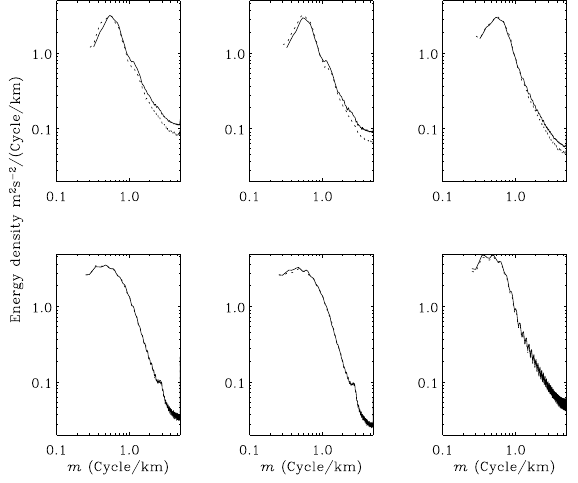
Fig. 4. Averaged vertical wave number spectra for the zonal ki- netic energy density (left column), meridional kinetic energy den- sity (middle column) and potential energy density (right column) in the troposphere (bottom row) and lower stratosphere (upper row) over Wuhan station. The solid and dotted curves denote the spectra at the local time of 08:00 and 20:00, respectively.